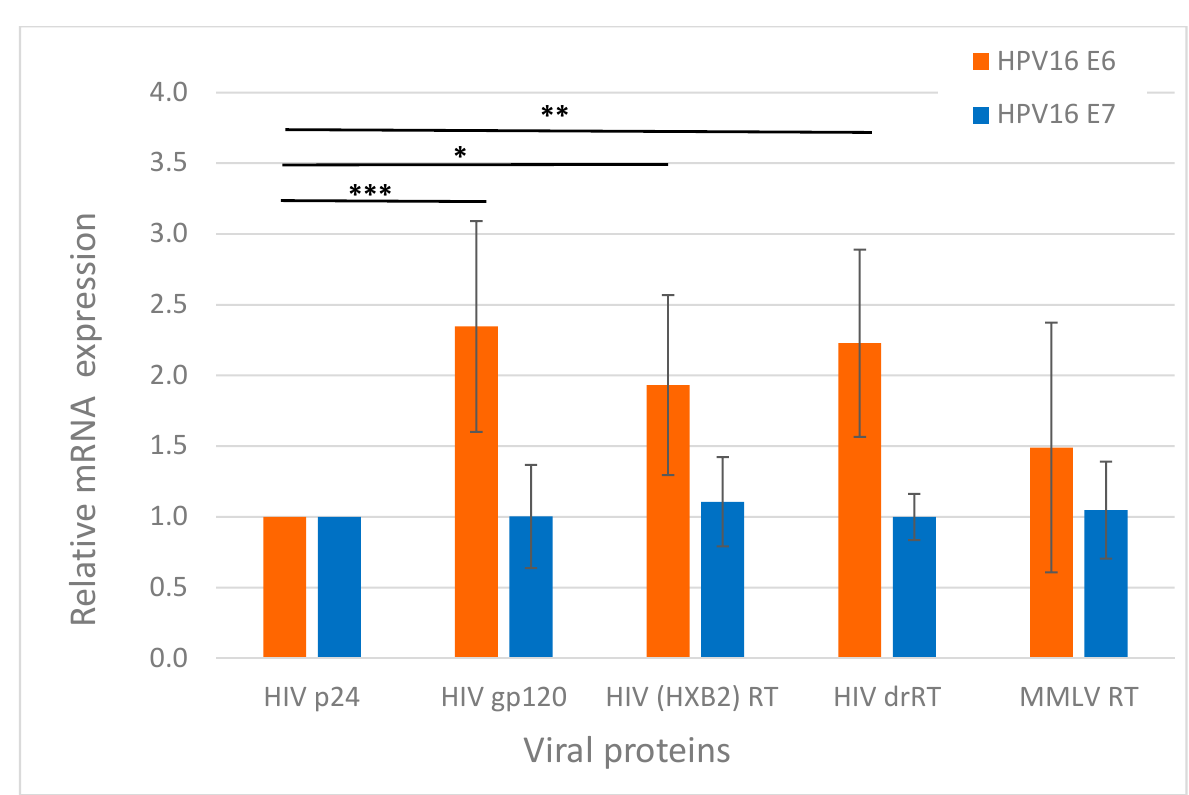
Figure 2. Transcription of oncoproteins E6 and E7 of HPV 16 in Ca Ski cells treated with HIV-1 proteins. Ca Ski cells harboring 600 full genomic copies of HPV 16 (ATCC CRL-1550) were cultured in RPMI-1640 medium (PanEco, Moscow, Russia) supplemented with 10% FBS and 100 mg/mL penicillin/streptomycin mix at 37 °C in an 5% CO 2 and split every 4 days. A panel of recombinant HIV-1 proteins: gp120 [113] ; p24 (NIBSC ARP 694.1); RT of HIV-1-1 clade B HXB2 strain [114], drug resistant (dr) RT of HIV-1-1 clade B isolated from patient with multiple drug resistance mutation (RT1.14; [114]) and RT of Moloney murine leukemia virus (MMTV) (CRIE, Moscow, Russia) were added to the culture medium, typically in concentration of 1 ng/mL, and incubated for 48 h, according to the methodology described previously by Lein K. et al. [115] Total RNA was extracted and reverse transcribed as described by Jansons et al. 2020 [116]. Gene-specific PCRs were performed on Rotor-Gene 6000 (Qiagen, Darmstadt, Germany) with SYBR Green kit (Evrogen, Moscow, Russia) with primers specific to HPV 16 E6 and E7 [117]. Expression of mRNA, assessed by the standard ddCt method, was normalized to expression of 18S RNA (18Srna_rt_f: GTAACCCGTTGAACCCCATT; 18Srna_rt_r: CCATCCAATCGGTAGTAGCG), and presented as fold change compared to cells treated with p24, as was recommended earlier [118]. Values represent mean ± SD from two independent assays run in duplicates. *** p < 0.001, ** p < 0.01, * p < 0.05 by the ordinary two-way ANOVA with Sidak’s multiple comparisons